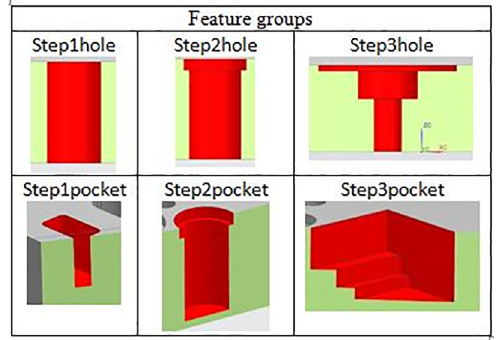
Fig. 4. Features divided into groups according to the number of steps found in the feature.